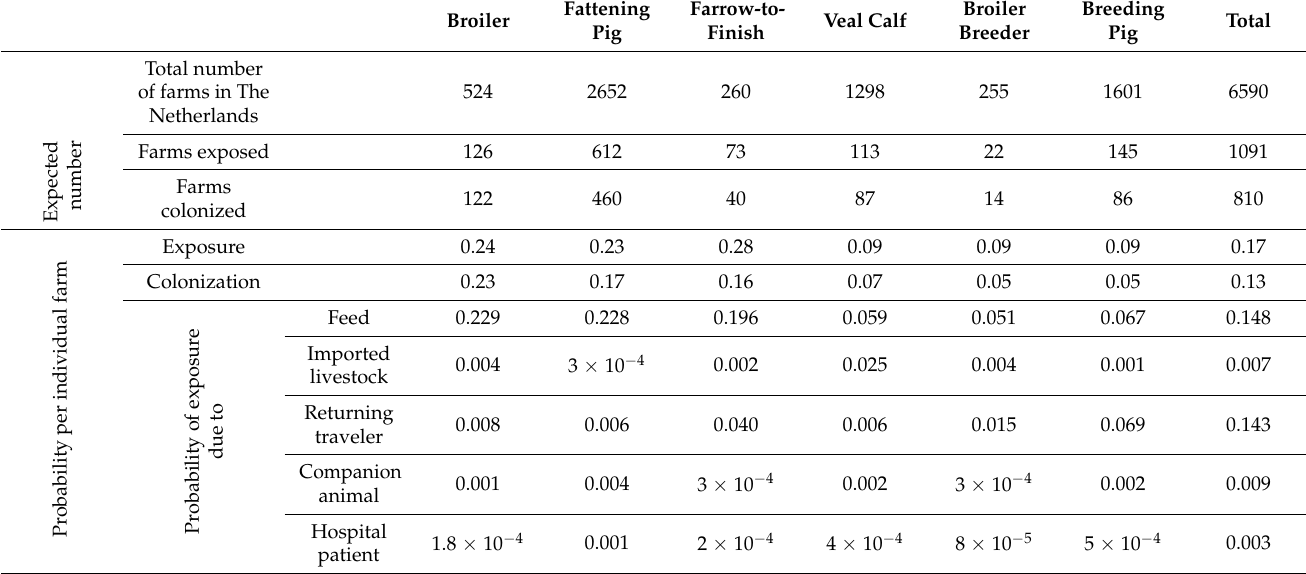
Table 2. Expected number of farms exposed and colonized combined with the total number of farms to calculate the probability of exposure and colonization for an individual farm of a specific